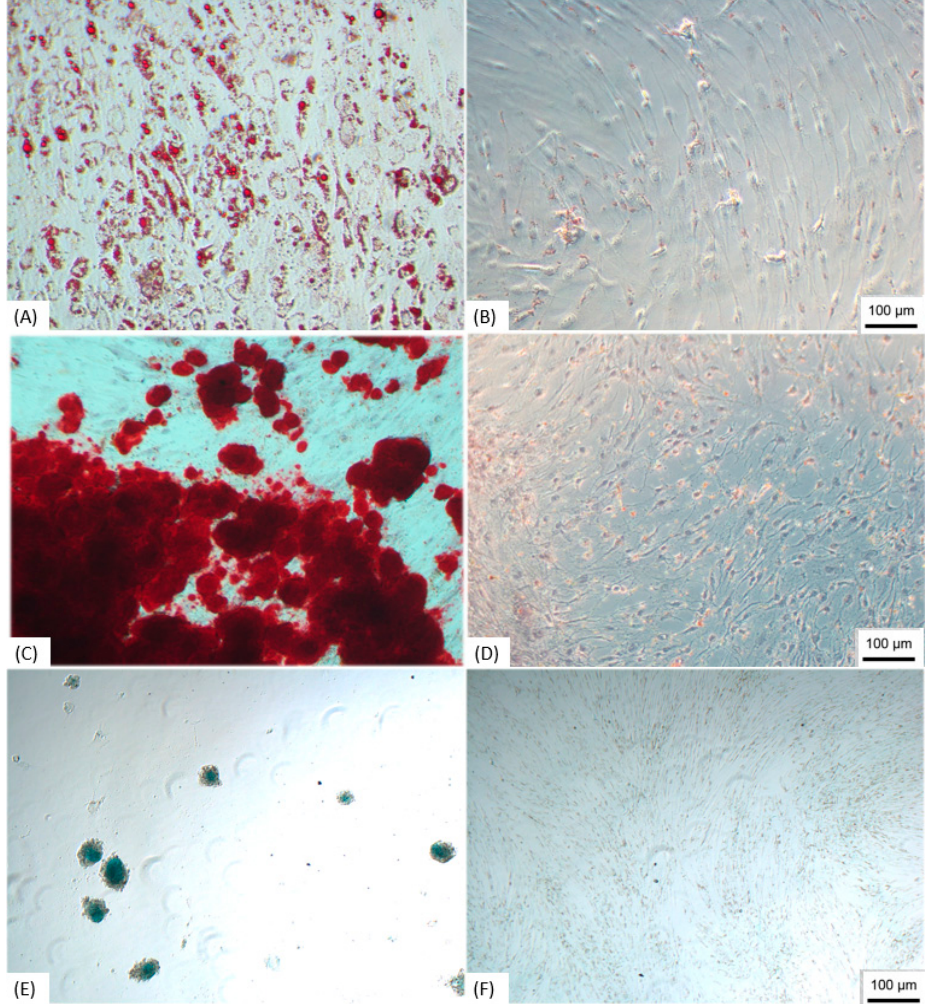
Figure 1. Trilineage differentiation. ( A ) ADMSCs submitted to adipogenic differentiation, staining the lipid vacuoles with Oil Red O; ( B ) Control of undifferentiated ADMSCs; ( C ) ADMSCs submitted to osteogenic differentiation showing mineralization stained with Alizarin Red; ( D ) Undifferentiated control; ( E ) ADMSCs differentiated in chondroblasts with the production of proteoglycans stained with Alcian Blue; ( F ) Undifferentiated control. Note: Image obtained by inverted optical microscopy, 100×—Axio Vert. A1, Zeiss, Germany). Scale bar, 100 µm. ADMSCs, adipose-derived mesenchymal stem cells.